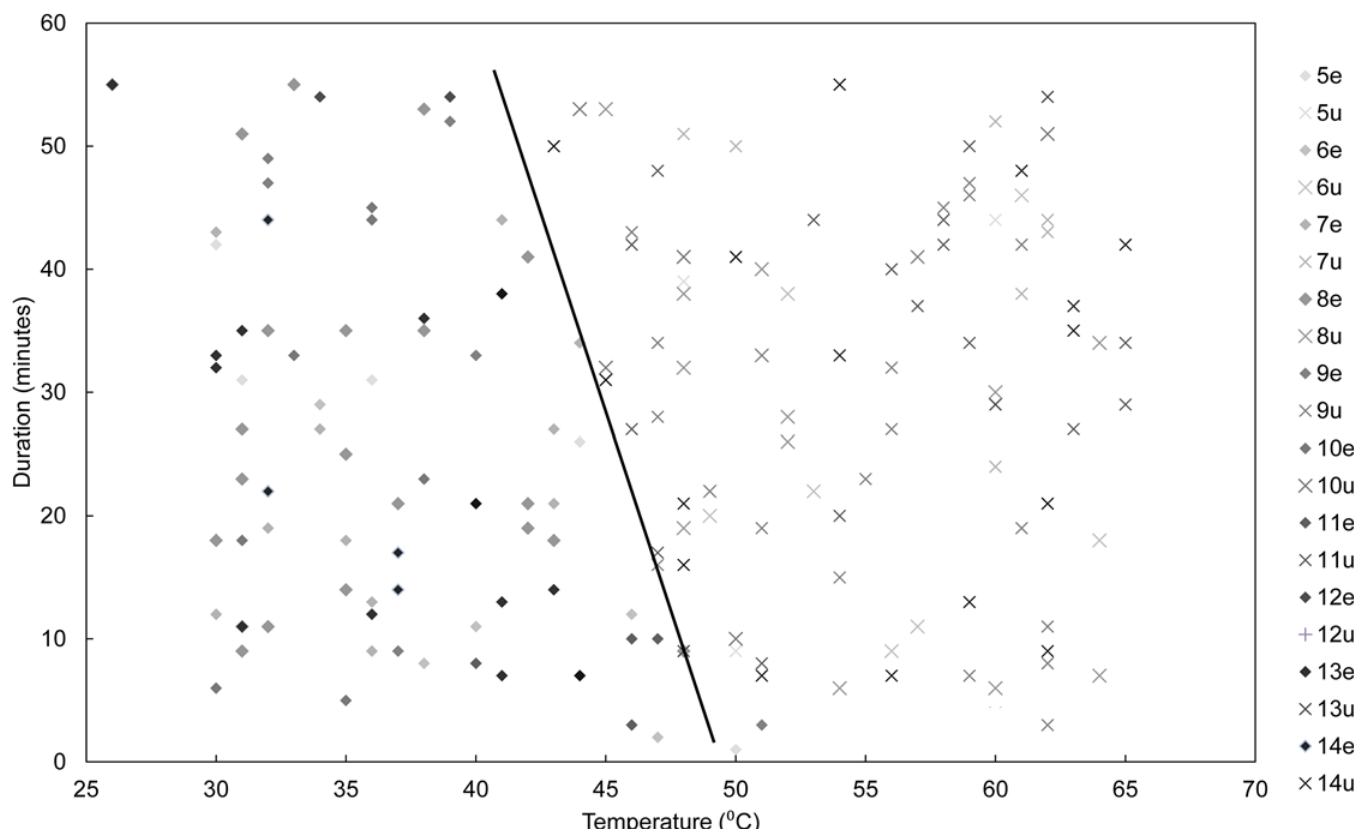
Fig 5. Plot of eclosion of E . atala following heated water bath treatment. ♦ = Successful adult eclosion, X = failure of adult to successfully eclose. Line represents a linear threshold between success and failure of E . atala to eclose into a viable adult following heated water bath treatment. Relative symbol darkness is related to age of pupae at the experiment (pupa age [eclosion status]).